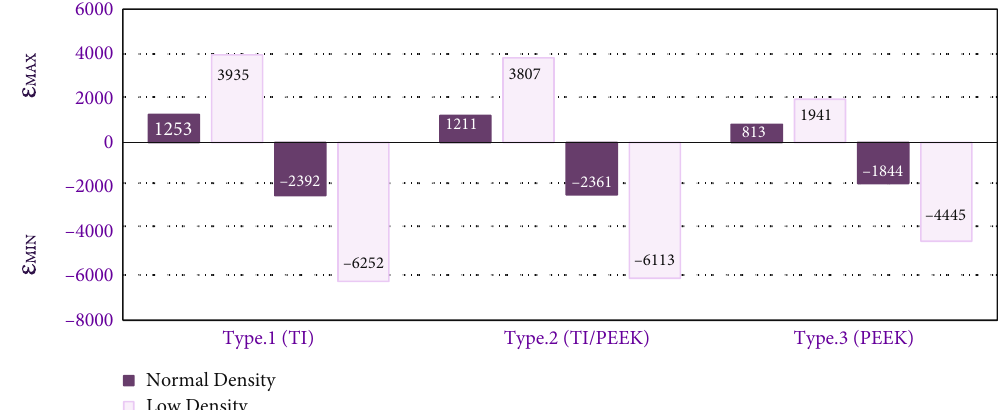
Figure 11: The distribution of maximum and minimum principal stresses (MPa) on cortical bone, in the low-density